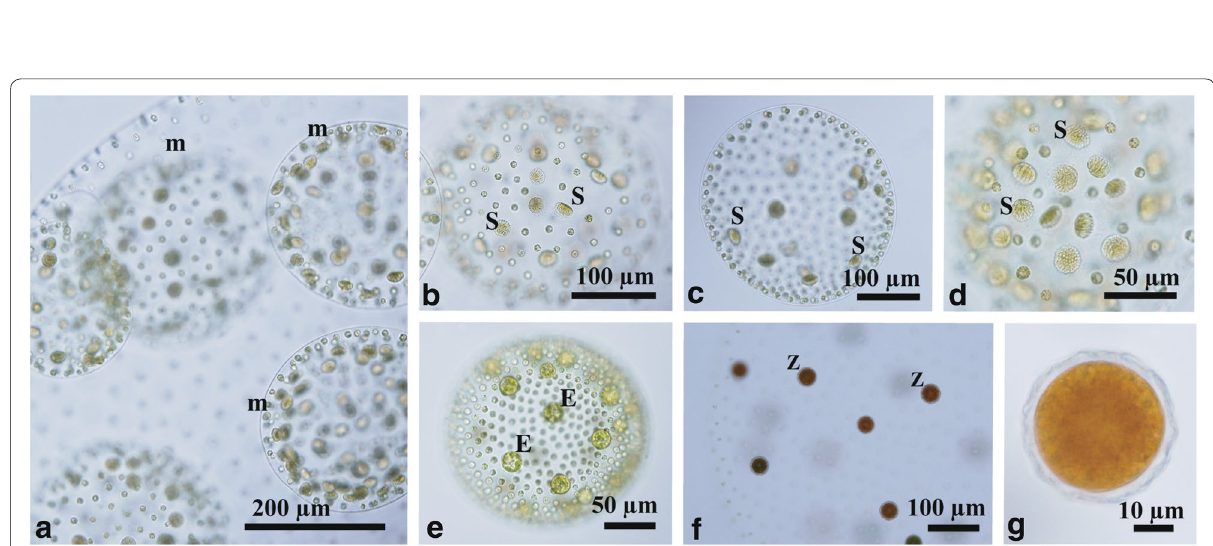
Fig. 2 Light microscopy of sexual reproduction in Taiwanese strains of Volvox carteri f. nagariensis . 2016‑tw‑nuk‑6‑1 (male) and 2016‑0609‑v‑1 (female). a Male spheroids (m) developing within parental spheroid. b – d Various ratios of somatic cells to sperm packets (S) in male spheroids. Note 4–12:1 ratio in ( a and b ), > 50:1 ratio in ( c ), and 1:1 ratio in ( d ). e Female spheroids with eggs (E). f Mature zygotes (Z) in female spheroid. g Optical section of mature zygote with reticulate